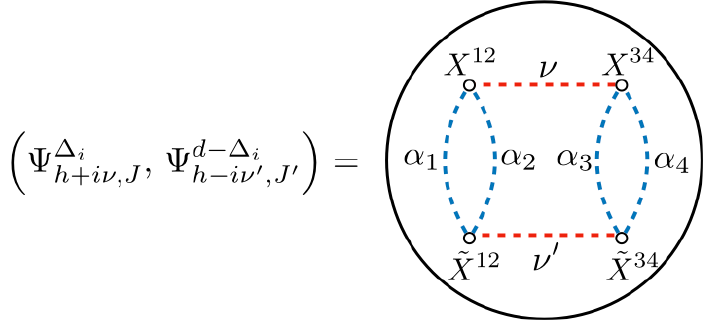
Figure 4 . The inner product of two (cid:9) (cid:23);J ( P i )s can interpreted as a bubble diagram in bulk. The bulk points are integrated over AdS.